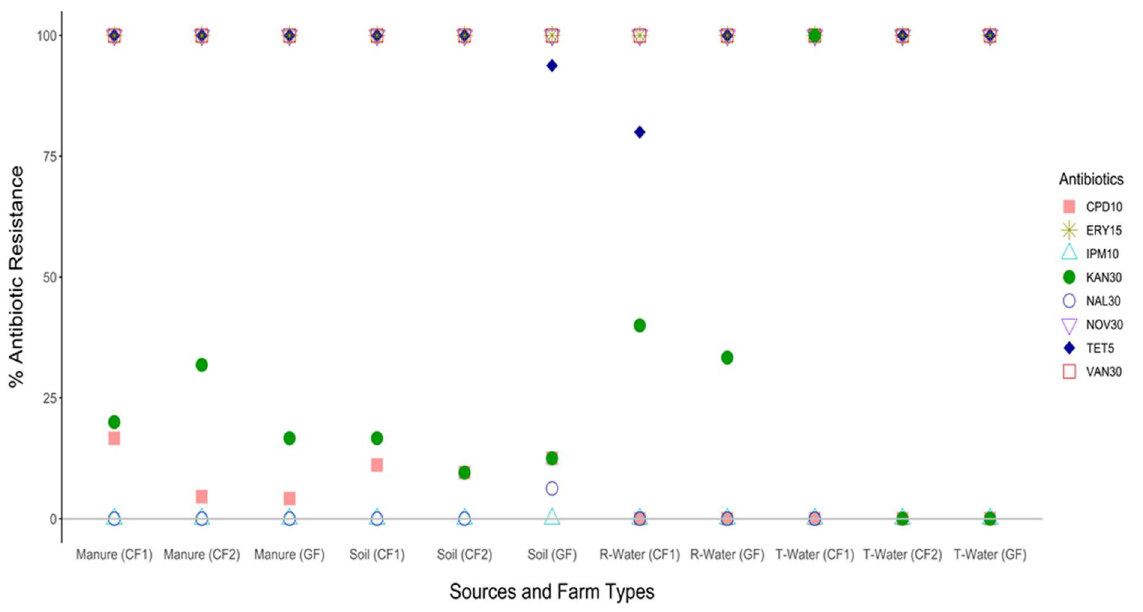
Figure 5. Percentage (%) resistance of Enterobacteriaceae isolated from different farm environment in cattle and goat farms. CF1: Cattle Farm 1; CF2: Cattle Farm 2; GF: Goat Farm. Antibiotic resistance phenotypes of Enterobacteriaceae isolates are shown in Table 4. Generally, Enterobacteriaceae isolates showed a total of four antibiotic resistant patterns: NOV-TET-ERY-VAN, NOV-ERY-VAN, NOV-TET-ERY-VAN-KAN, and NAL-NOV- Bacterial TET-ERY-VAN. E. coli isolates displayed three antibiotic resistant patterns: NOV-TET- ERY-VAN ( n = 87; CF1 = 30, CF2 = 32, GF = 25), NOV-ERY-VAN ( n = 25; CF1 = 12, CF2 = 5, and GF = 8), and NOV-TET-ERY-VAN-KAN ( n = 1; CF1 = 1). Notably, Yersinia enterocolitica displayed one resistant pattern: NOV-ERY-VAN (CF1 = 1). Table 4. Antibiotic resistance phenotypes of Enterobacteriaceae isolated from cattle and goat farms.